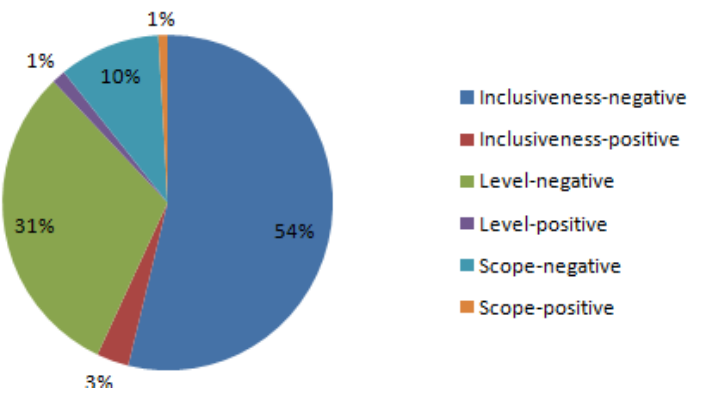
Figure 7. Current EU set-up (n = 223).